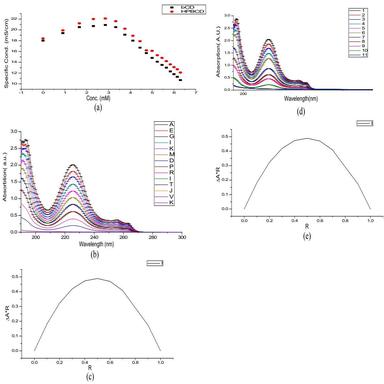
(a) The variation of specific conductance of DMPI with respect to the concentration for HP-β-CyD at room temperatures (298 K). (b) and (c) Uv–vis graph (Plot with standard deviation data) & corresponding Job plot for DMPI and HP-β-CyD with maxima at 0.5; (d) & (e) Uv–vis graph (Plot with standard deviation data) & corresponding Job plot for DMPI and β-CyD with maxima at 0.5.